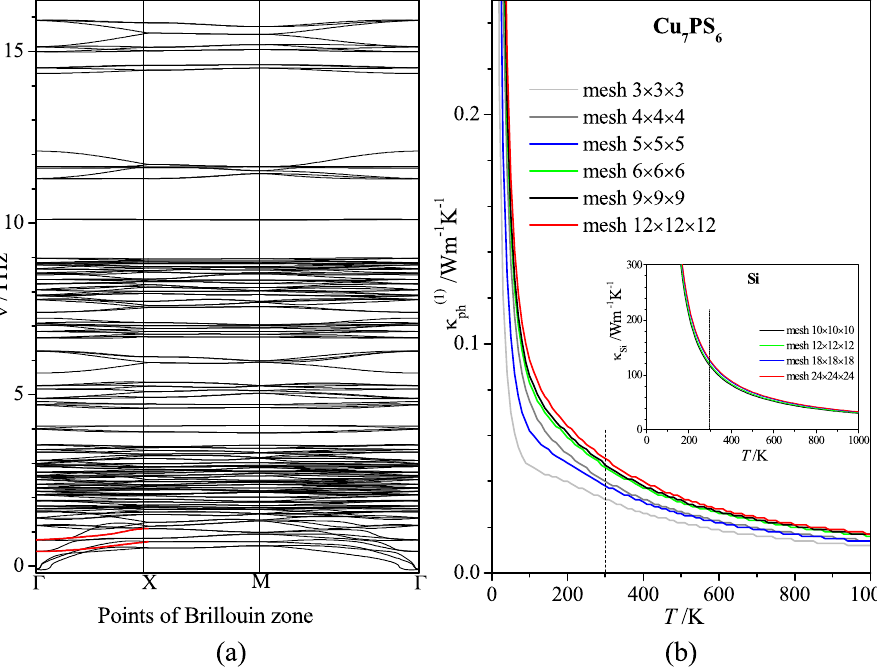
Figure 7. ( a ) Dispersion of the phonon modes ν( q ) and ( b ) temperature dependences of lattice thermal conductivity coefficient κ ph (1) of Cu 7 PS 6 obtained using different q -meshes of the inverse lattice. In the inset, temperature dependences of lattice thermal conductivity coefficient κ ph (1) for different q -meshes of silicon crystal obtained using the same Phono3py code, v.2.0.0, https:// phono py. github. io/ phono 3py/ index.